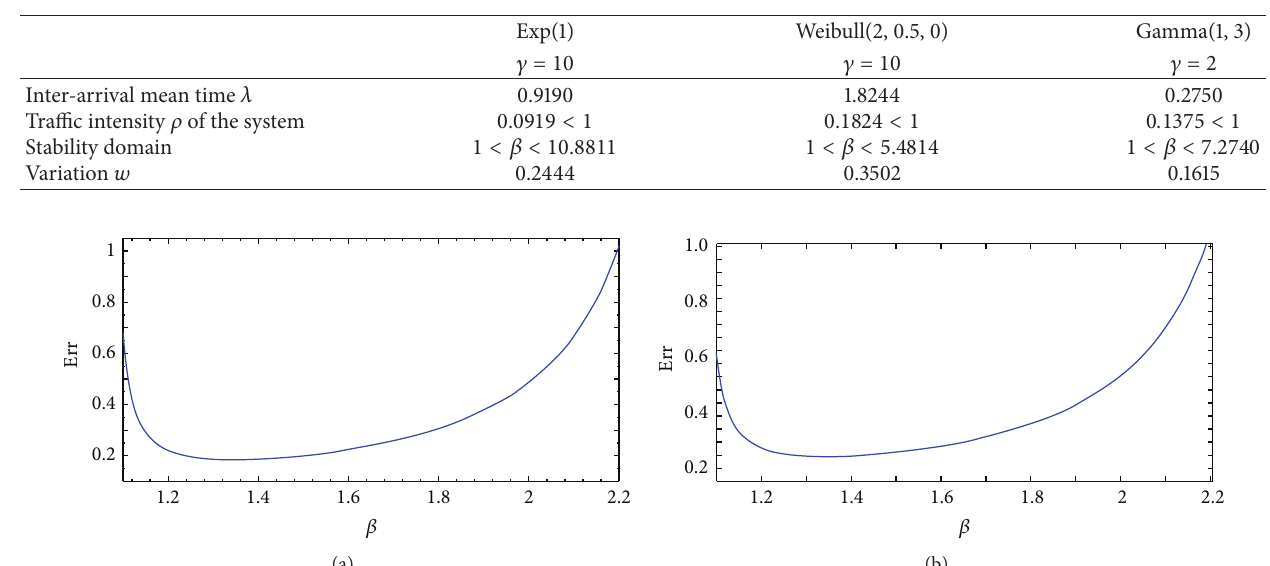
Table 2: 𝑤 and Err measures with different samples.